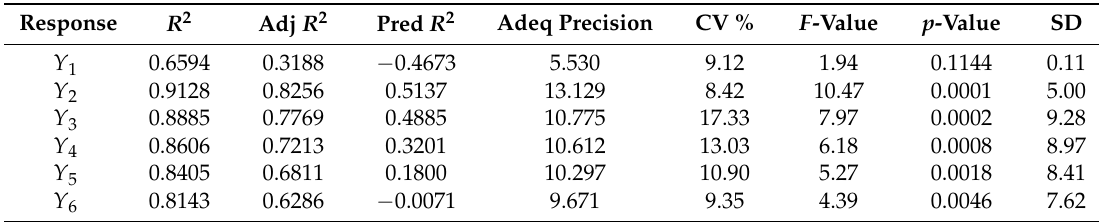
Table 2. ANOVA data generated for RSM model.